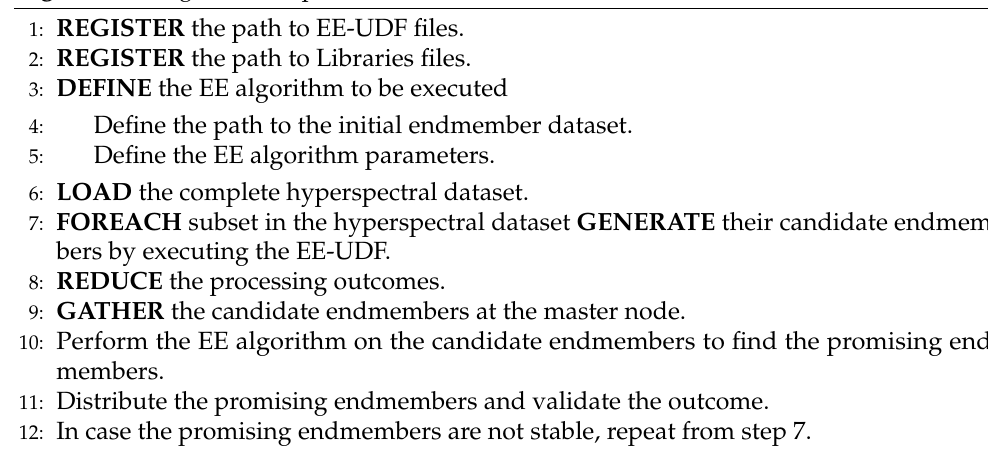
Algorithm 2 Pig Latin script for the Endmember Extraction Process